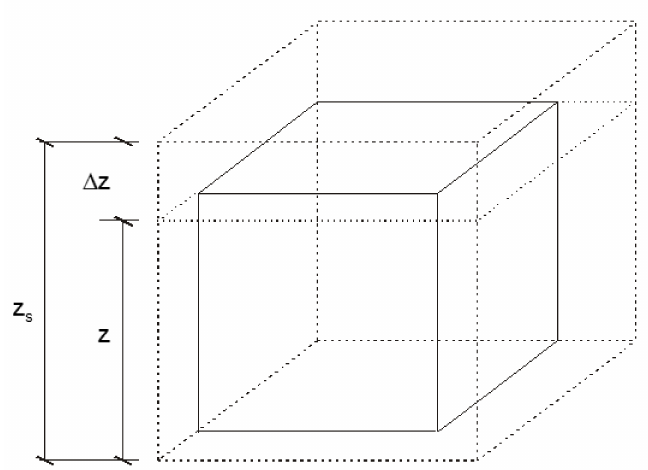
Figure 1. Change in the isotropic state of a cube shaped soil sample during drying. A dotted line shows the sample in saturated state, volume V s , with an edge length z s . The full line shows the sample after shrinkage, volume V , with an edge length z s . Change of the cube edge length after drying is ∆ z